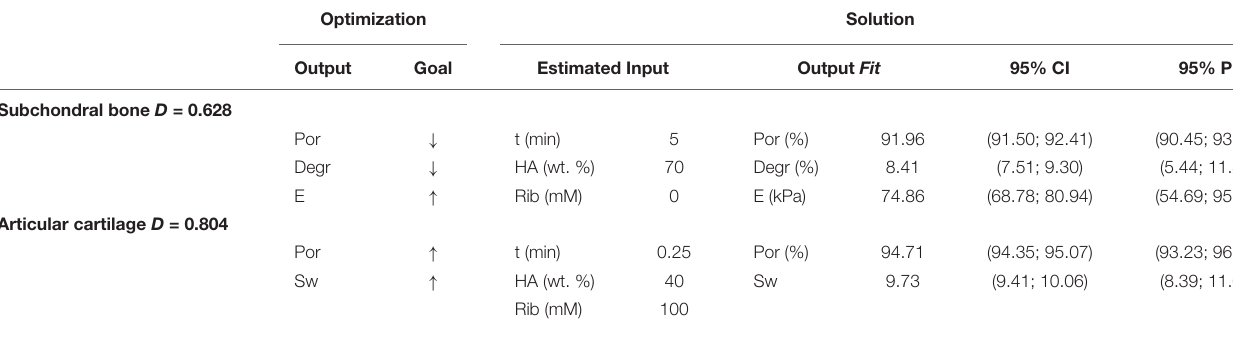
TABLE 3 | Optimization values and simulation solutions (estimated input, output fit and statistical intervals) for subchondral bone and calcified cartilage, where ↓ = min, ↑ = max, D = Composite Desirability (0–1), CI = Confidence Interval, PI = Prediction Interval.